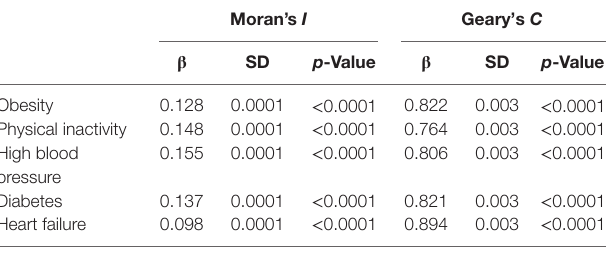
TaBle 2 | Spatial autocorrelation analysis of the study factors across the counties.